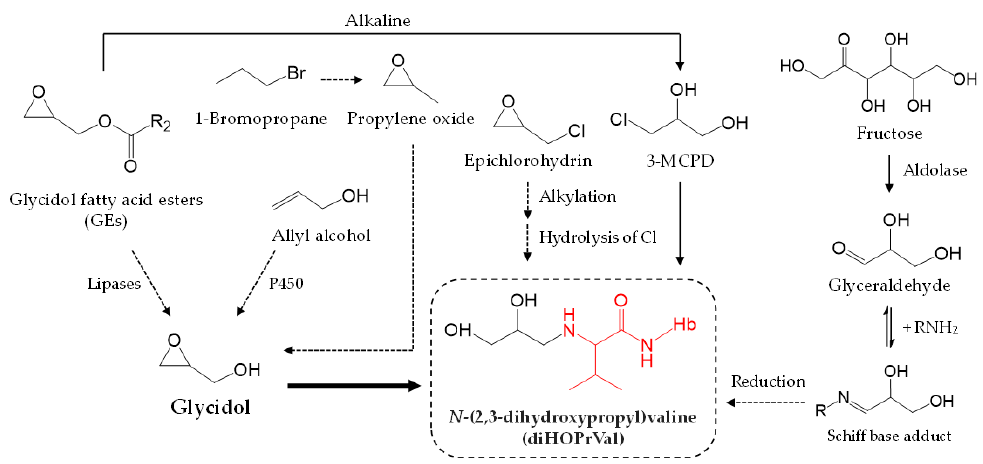
Figure 1. Examples of possible precursors to N -(2,3-dihydroxypropyl)valine cf. [16,19].